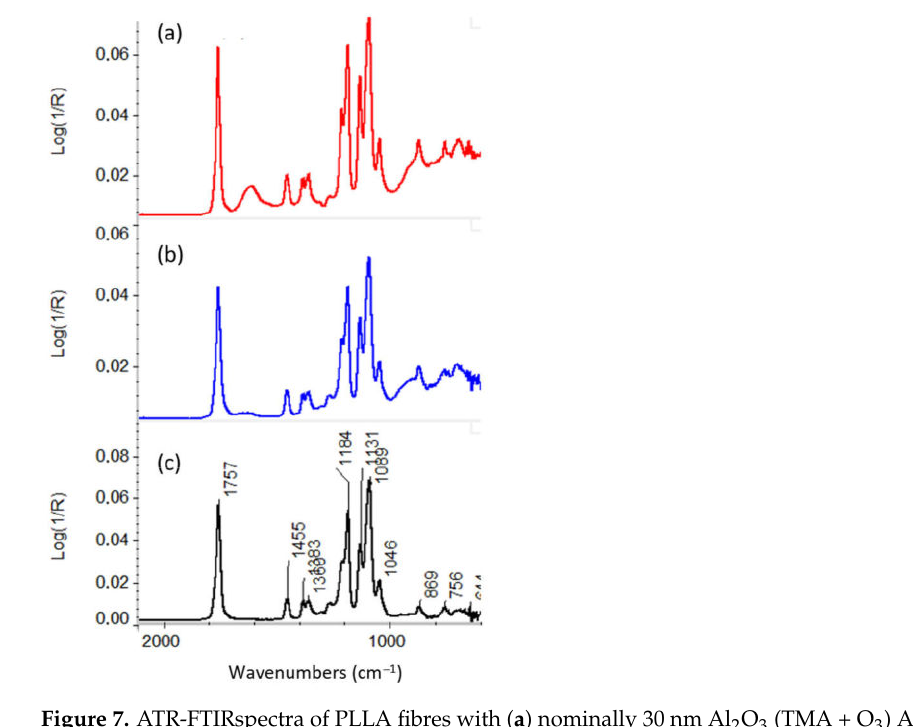
Figure 7. ATR-FTIRspectra of PLLA fibres with ( a ) nominally 30 nm Al 2 O 3 (TMA + O 3 ) ALD coating (red) ( b ) nominally 30 nm Al 2 O 3 (TMA + H 2 O) ALD coating (blue), and ( c ) uncoated fibres (black).